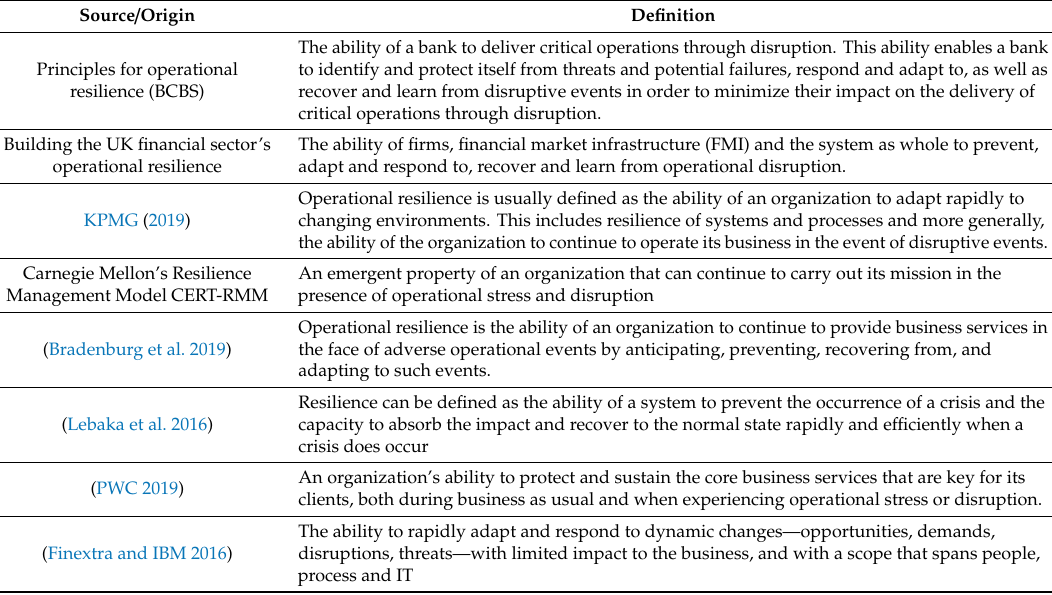
Table 1. Definitions for operational resilience available from various